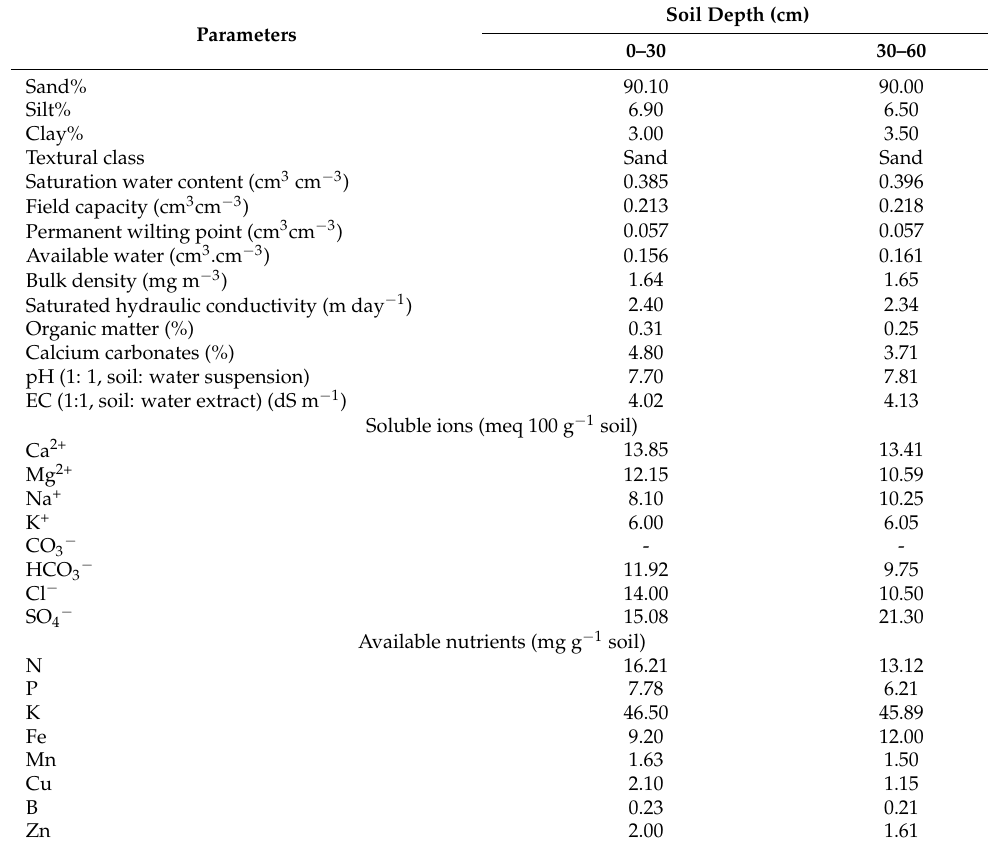
Table 1. Initial soil properties of the experimental site.